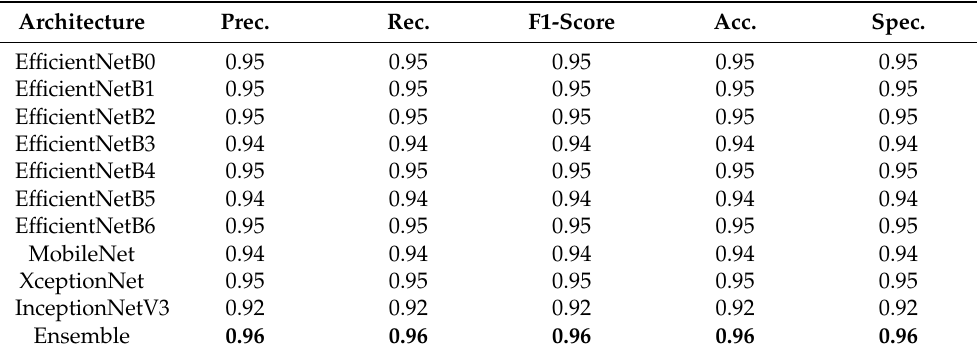
Table 5. Results for the two-class classification. The best results for each metric are highlighted in